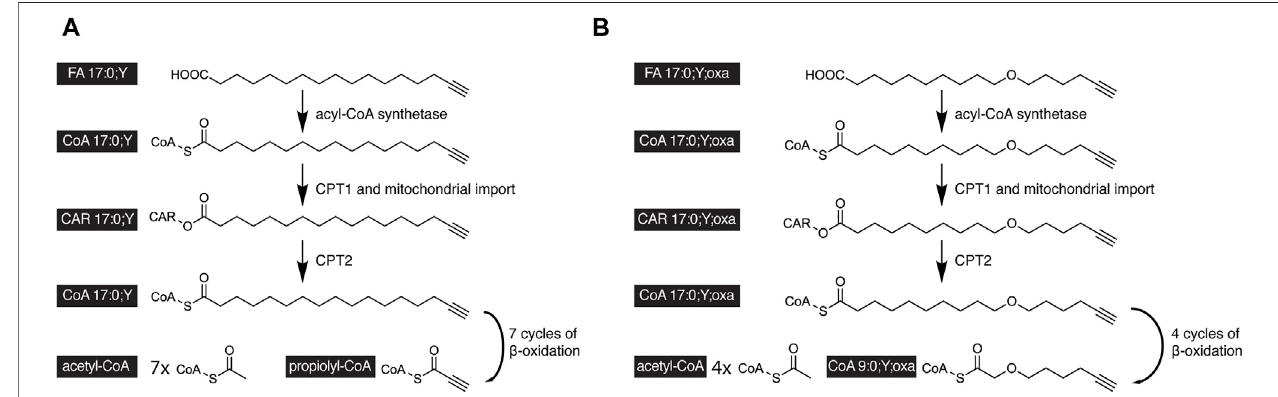
FIGURE 4 | Scheme of the catabolic degradation of alkyne-labeled tracers of palmitate. (A) In cells, the alkyne analog FA17:0;Y and (B) oxaalkyne analog FA 17:0;Y;oxaare activated by an acyl-CoAsynthetasebeforecarnitin palmitoyltranferase1(CPT1) forms thecorrespondingcarnitineesters,that aresubjectto mitochondrial uptake. Intra-mitochondrial CPT2 regenerates the acyl-CoAs, which undergo cyclic β -oxidation. After seven β -oxidation cycles, the FA 17:0;Y yields seven molecules of acetyl-CoA and the unstable propiolyl-CoA (A) . After four β -oxidation cycles, the FA 17:0;Y;oxa yields the end product FA 9:0;Y; oxa as CoA thioester containing a stable alkyne label (B)